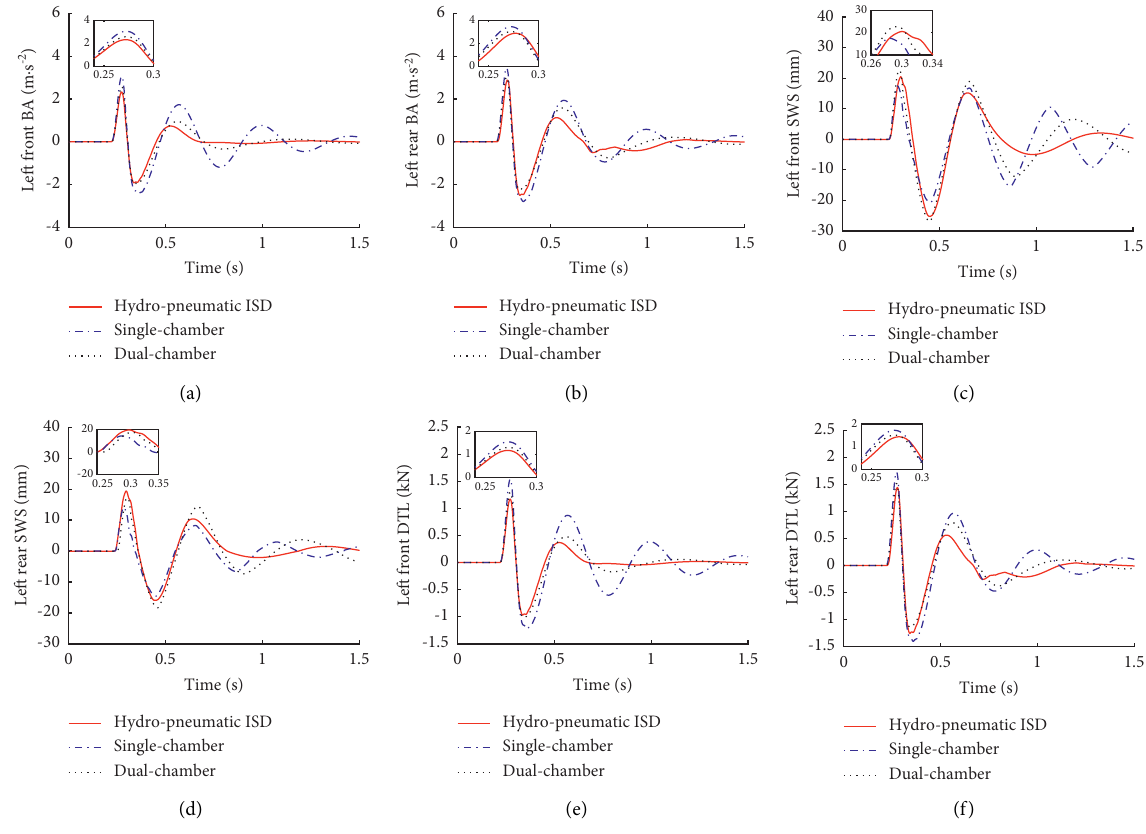
Figure 7: Comparison of pulse input response for simulation. Table 3: PTP values of pulse input response for simulation.